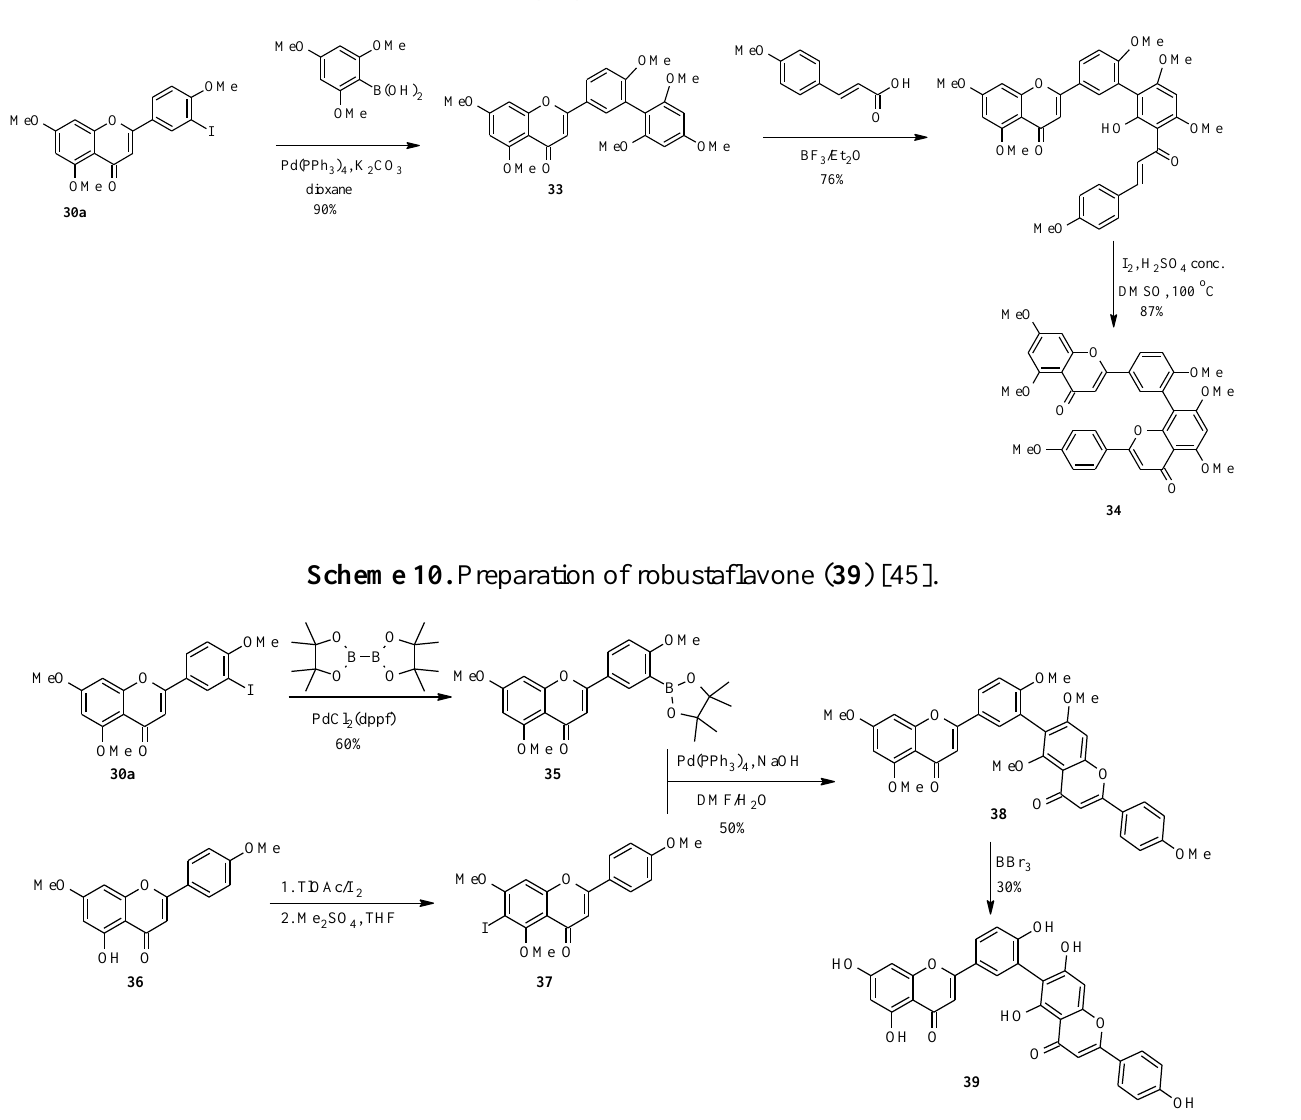
Scheme 9. Second route for the preparation of amentoflavone derivatives [44].